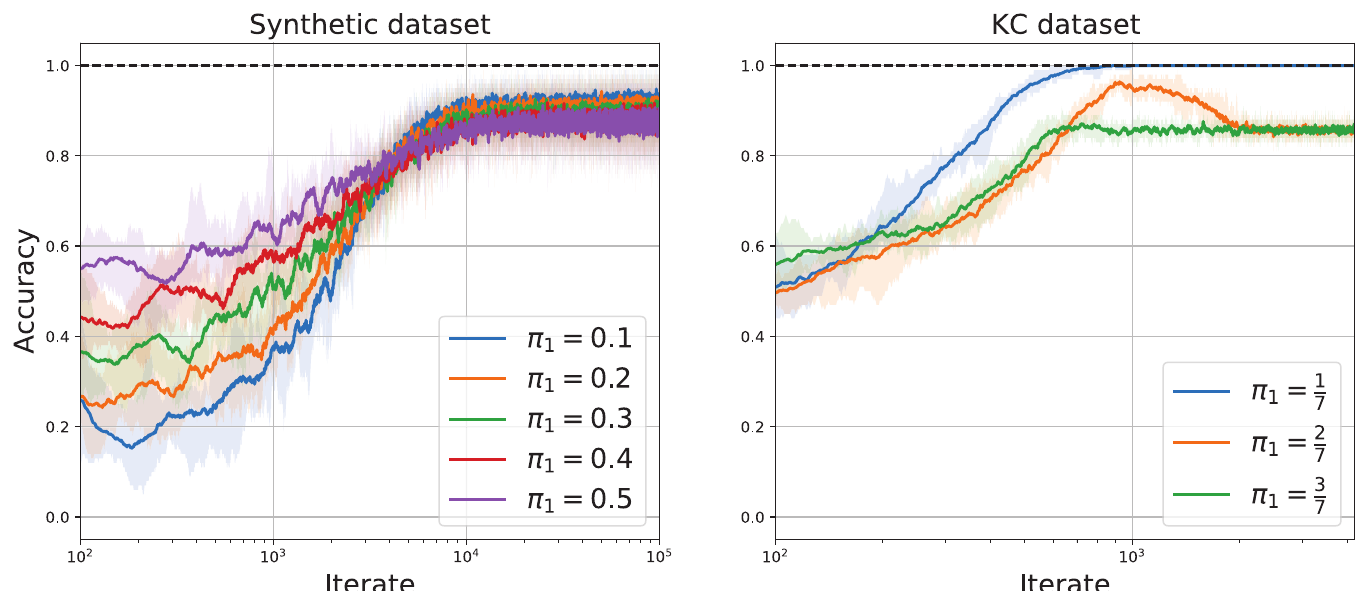
Fig 3. Performance of Algorithm 1. Accuracy of Algorithm 1 on the synthetic datasets (left) and the KC dataset (right). Each line denotes the mean accuracy over 10 runs. Each shaded region indicates the area between the minimum and maximum accuracy over 10 runs.